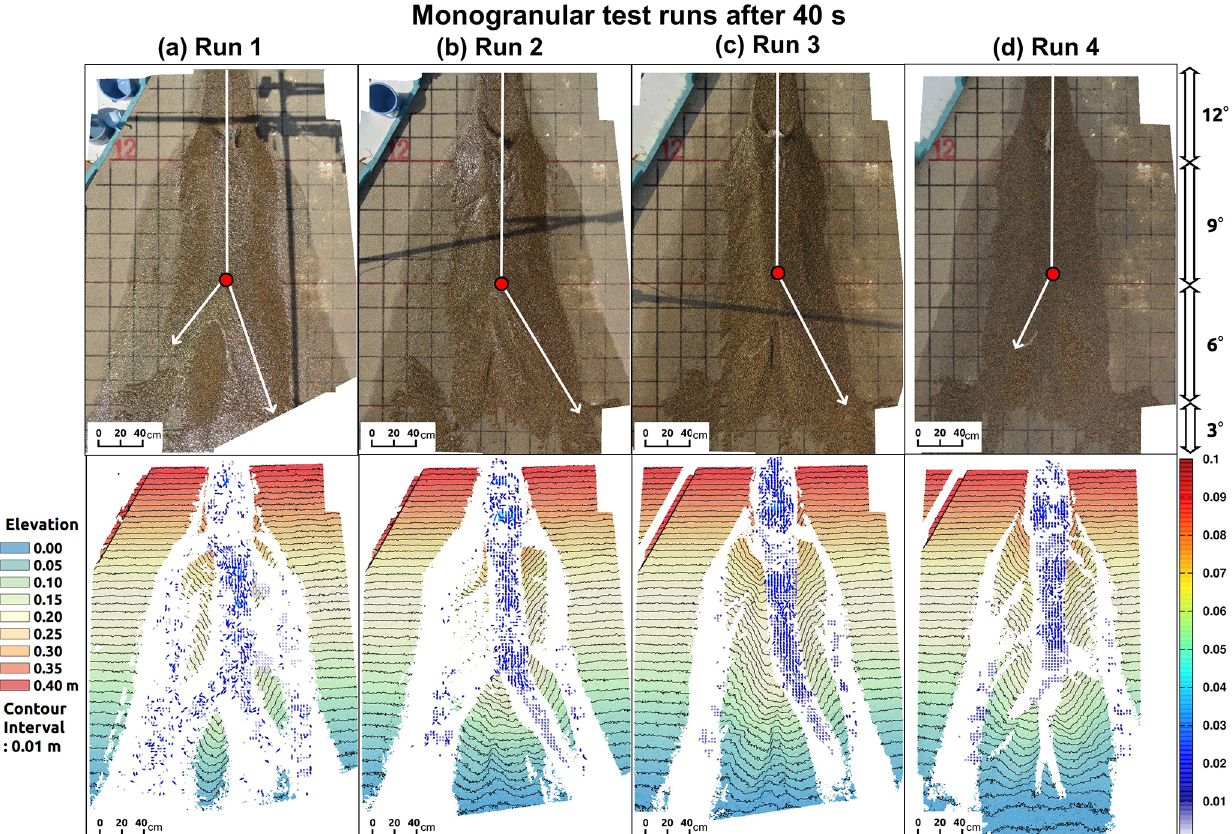
Figure 12. Fan morphology 40s after the start of runout of the monogranular flows. The upper and lower panels show orthophotos and digital elevation models (DEMs) with flow vectors, respectively. Respective sets of the upper orthophoto and lower DEM represent corresponding results of each experimental test run. The white arrows on the orthophotos indicate the assumed principal direction of flow descent. The red points in the orthophotos indicate the assumed occurrence point of the avulsion. The elevation of the DEMs is depicted assuming that the area with a 3 ◦ slope (i.e., the area furthest downstream from where the slope angle changed from a 6 to 3 ◦ slope) has elevation of